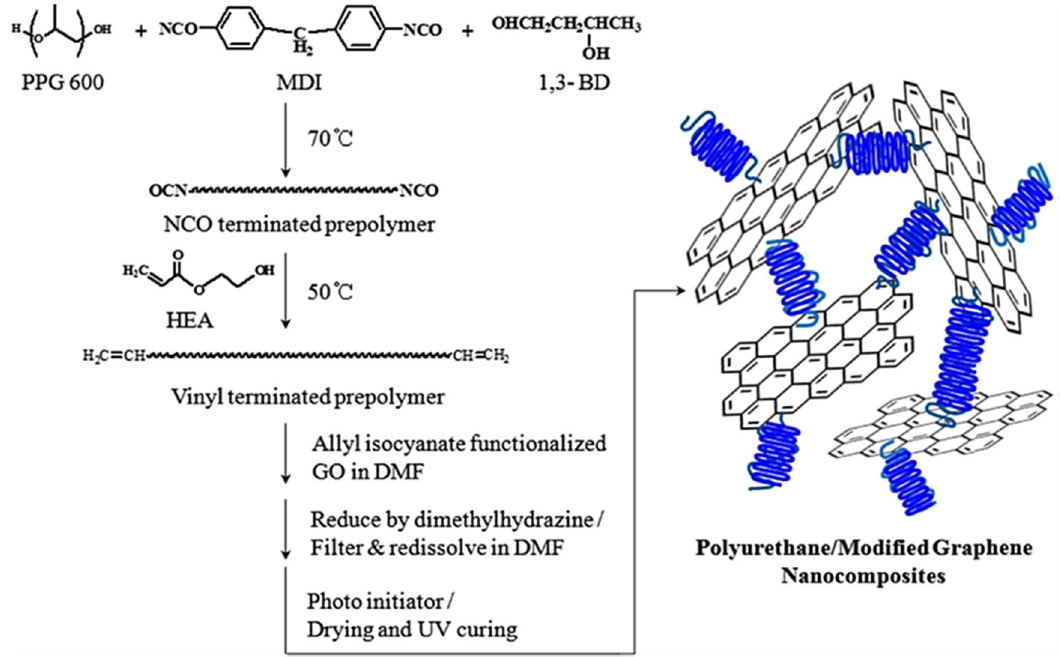
Figure 7: Scheme for preparation of polyurethane/graphene nanocomposite ( 103 ) . HEA – hydroxyethylacrylate; DMF – N , N - dimethylfor - mamide; GO – graphene oxide; 1,3 - BD – 1,3 - butanediol; PPG – polypropylene glycol; MDI – 4,4 ′ - methylene diphenyl diisocyanate. Repro - duced with permission from Wiley.